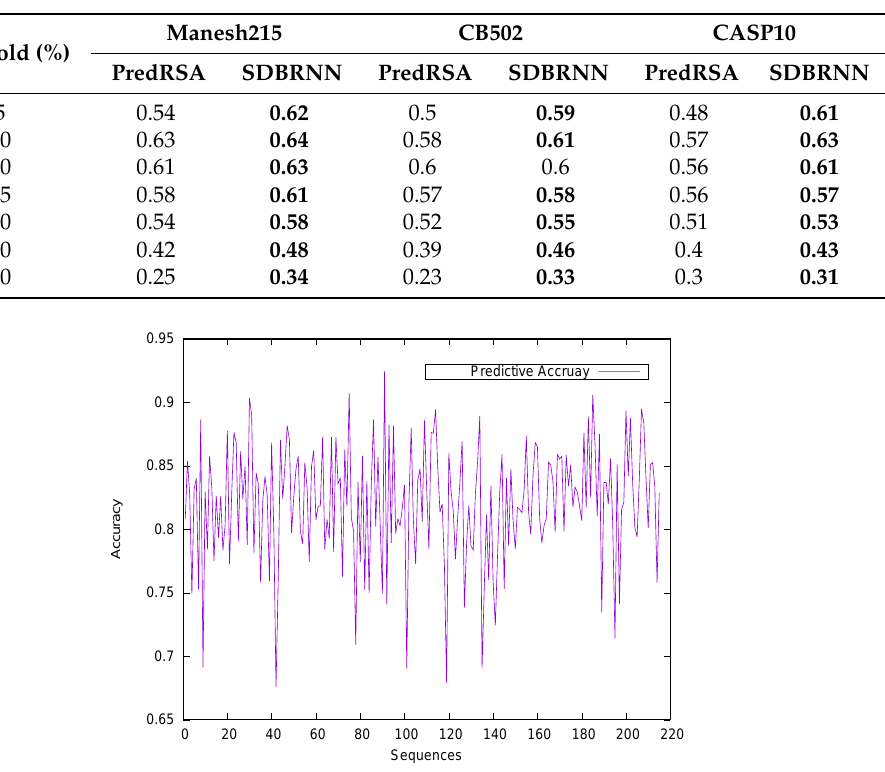
Table 5. Matthews’ correlation coefficient performance comparison in binary classification prediction.